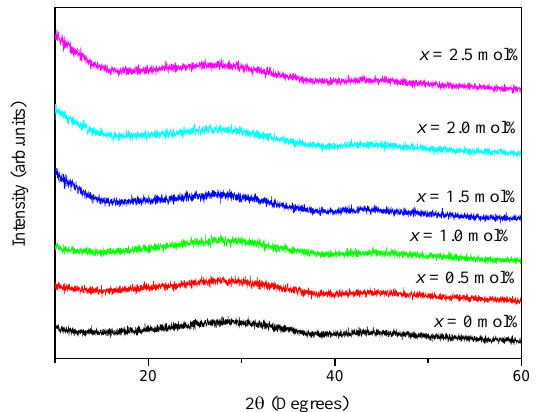
Figure 1. XRD patterns of (59.5– x ) B 2 O 3 –20Na 2 O–20CaO– x V 2 O 5 –Er 2 O 3 –0.5AgCl ( x = 0, 0.5, 1.0, 1.5, 2.0 and 2.5